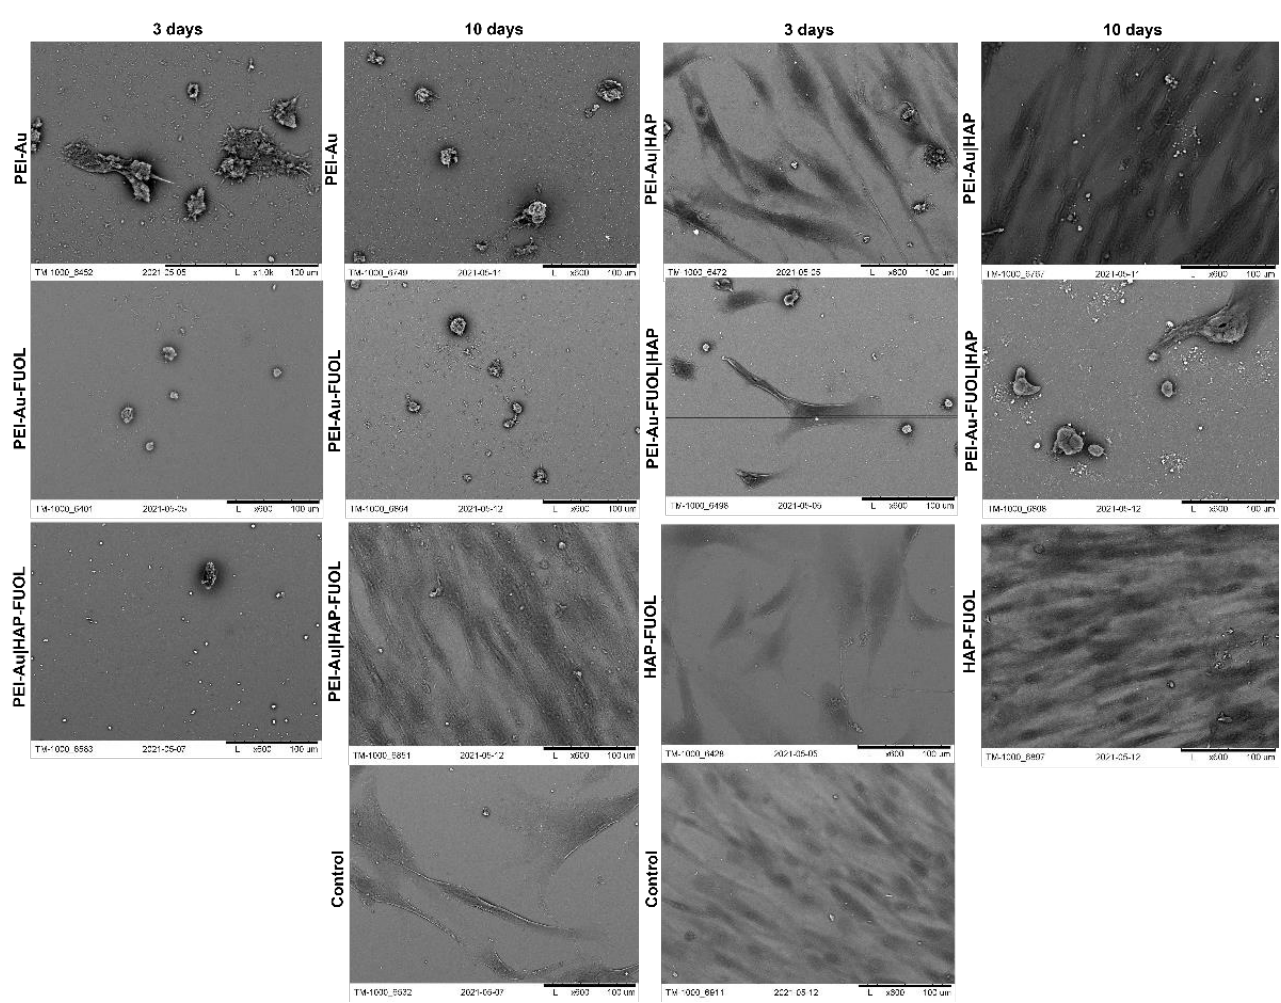
Figure 7. SEM visualization of HDF cells immobilized within designed scaffolds after 3- or 10-day culture. As a control, served cells cultured on glass slides without the membranes. Key to the symbols: PEI-Au: the membrane built of the polyethylenimine with AuNPs incorporating; PEI-Au|HAP: bilayer consisting of polyethylenimine with AuNPs incorpo- rating and hydroxyapatite; PEI-Au-FUOL: polyethylenimine with AgNPs and FUOL incorporating; PEI-Au-FUOL|HAP bilayer consisting of polyethylenimine with AuNPs and FUOL incorporating and hydroxyapatite; PEI-Au|HAP-FUOL bilayer consisting of polyethylenimine with AuNPs incorporating and hydroxyapatite with FUOL incorporating; HAP-FUOL: hydroxyapatite with FUOL incorporating. Scale bar: 100 µm.